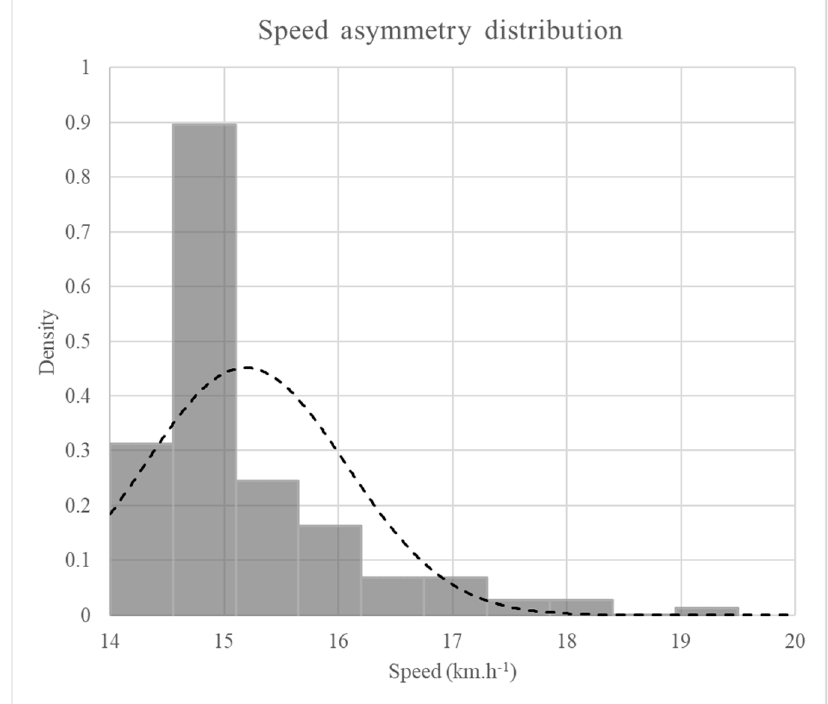
Figure 1. An example of a right-/positively skewed speed distribution (the bar chart) for participant 1 in the TT3 3000 m time trial.